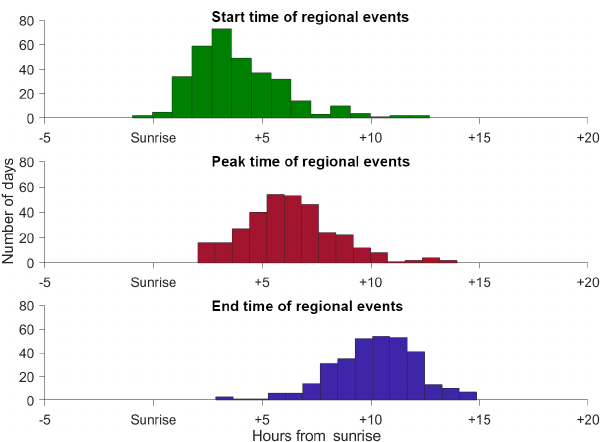
Figure 6. Frequency of days during spring at which regional events start, peak and end past sunrise. For example, most events start within 3h from